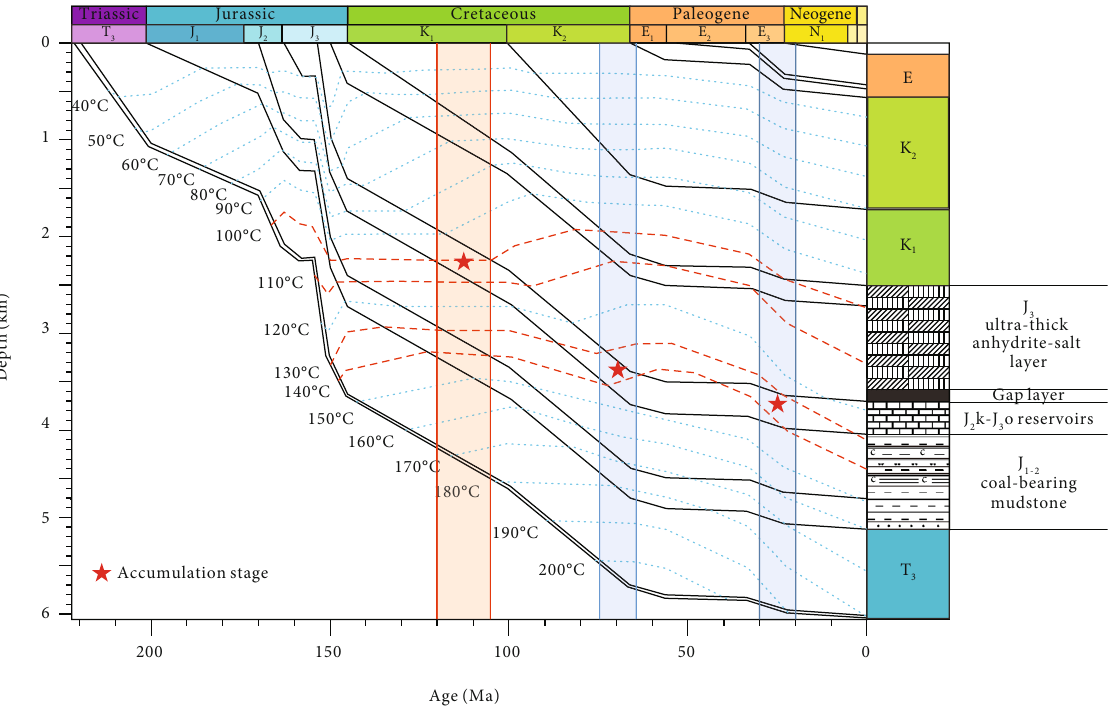
Figure 10: Burial-thermal history curves of Well AMO-2 in the middle section of the ADRRB.